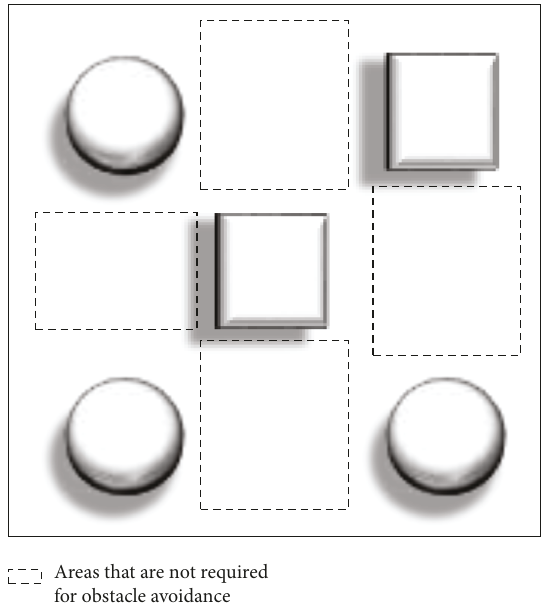
Areas that are not required for obstacle avoidance Figure 2: Collection status of areas not required for obstacle avoidance.